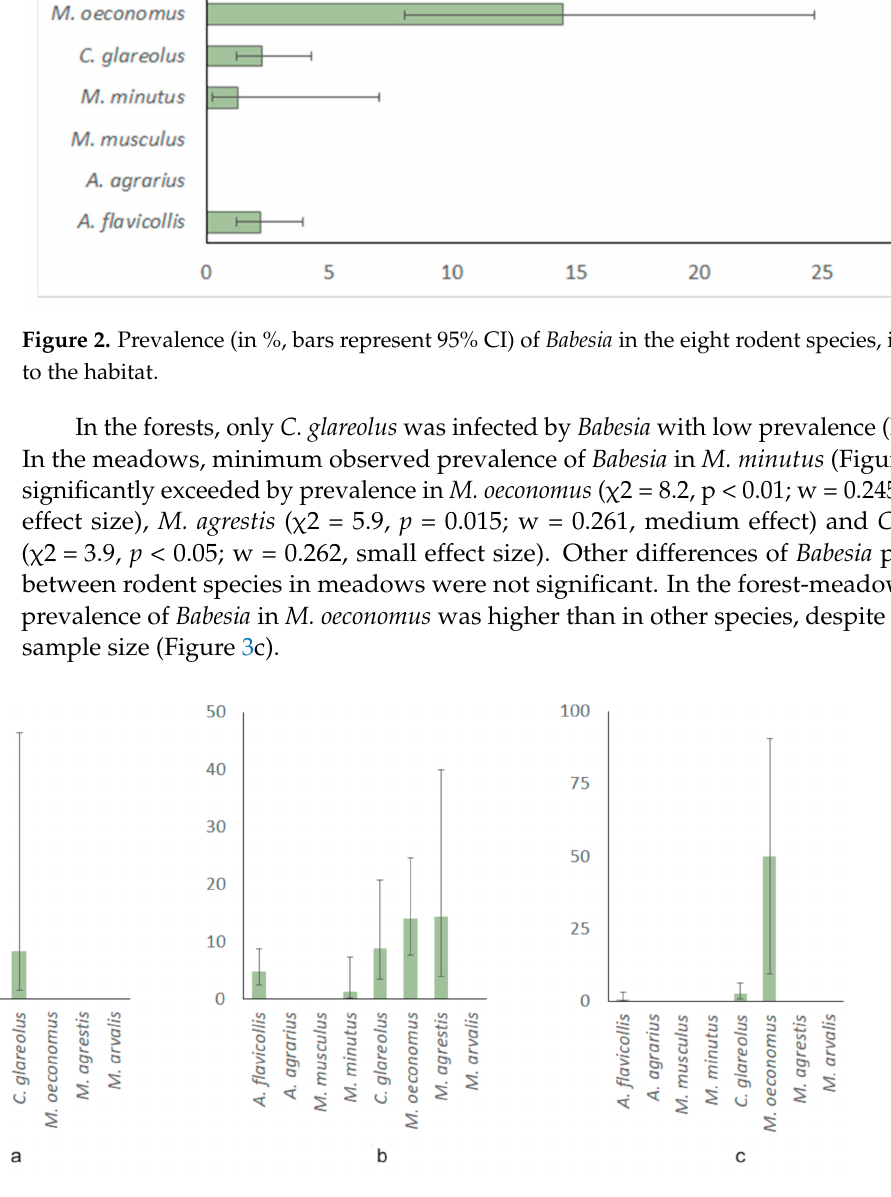
Figure 3. Habitat-based differences of prevalence (in %, bars represent 95% CI) of Babesia in the eight rodent species: ( a ) forests, ( b ) meadows, ( c )